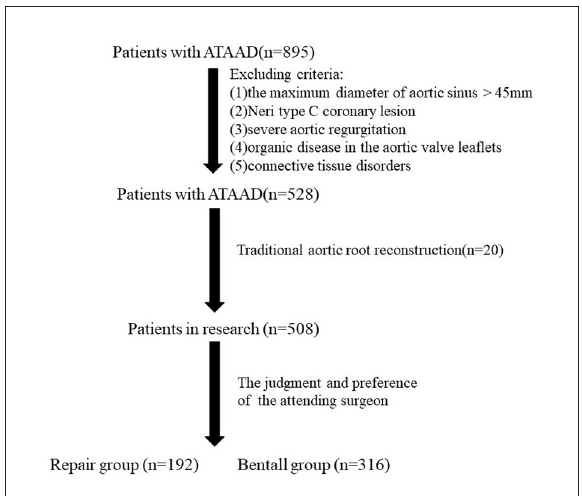
FIGURE1 The study flow chart. ATAAD, acute type A aortic dissection.